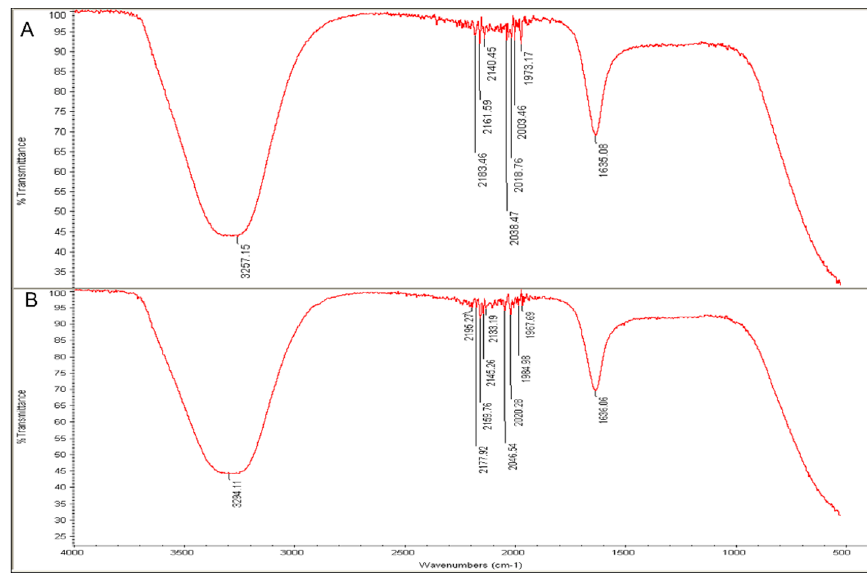
Figure 9. FTIR absorbance peaks of aqueous extracts of L. frutescens ( A ) and L-AgNPs ( B ) presenting peaks of the extract organic materials.